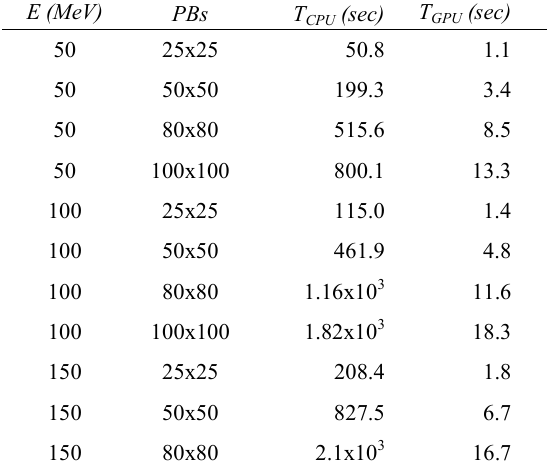
Table 1. Geometris used in performance evaluation